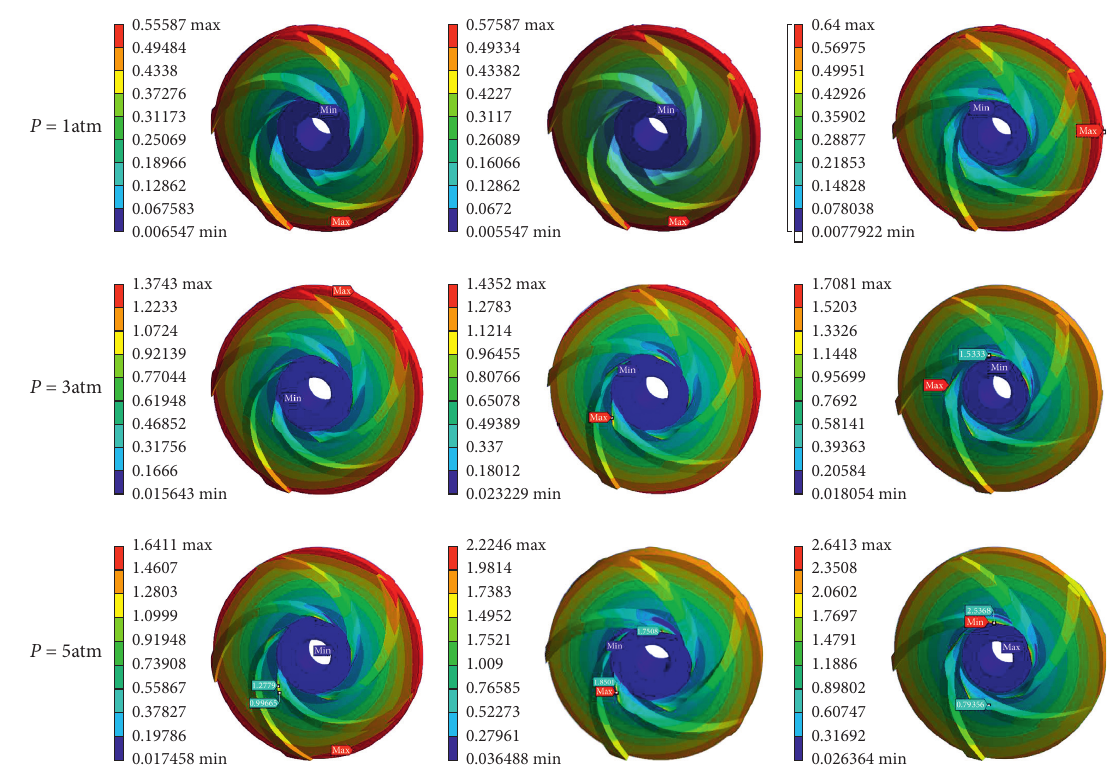
Figure 16: Impeller deformation under different outlet